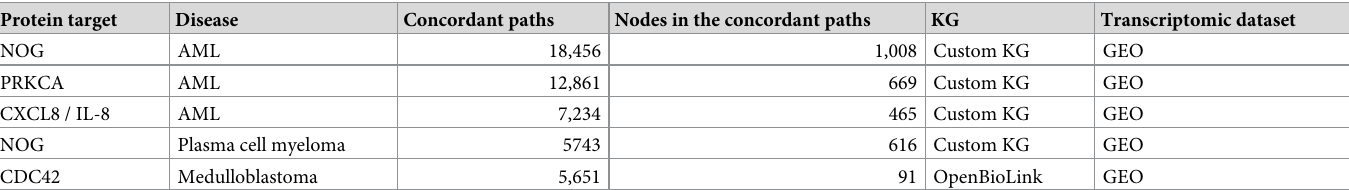
Table 2. Top 5 prioritized protein target-disease pairs. These results were obtained by running RPath over both KGs with the GEO and Open Targets datasets using the same path length as the drug discovery task (see Methods) . Pairs were prioritized based on the number of concordant paths. The vast majority of pairs were prioritized using the disease transcriptomic signatures from the GEO dataset given its larger coverage of measured genes compared to Open Targets (S4 Table) . Protein